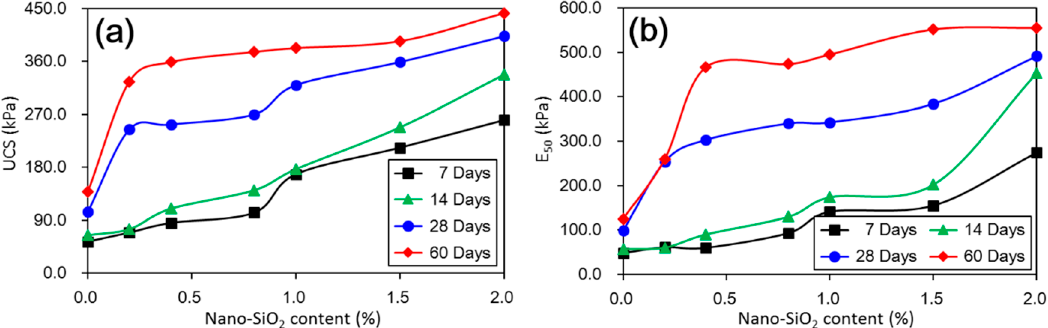
Figure 4. ( a ) Unconfined compressive strength (UCS) values of treated loess with different nano-SiO 2 contents and curing days; ( b ) E 50 values of treated loess with different nano-SiO 2 contents and curing days.